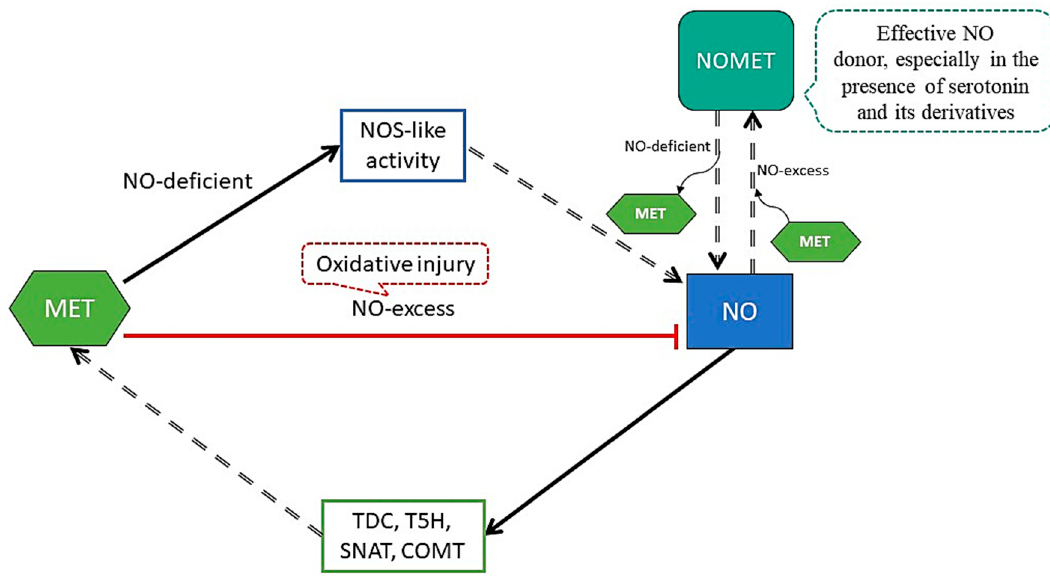
Figure 4. Interaction between melatonin (MET) and nitric oxide (NO). MET promotes the accumulation of NO by increasing the activity of NOS (nitric oxide synthase)-like since MET up-regulates the expression of related genes. MET scavenges excess NO, as it produces oxidative injury (red arrow). In the presence of oxygen, MET can be easily converted to N-Nitrosomelatonin (NOMET) by NO nitrosation under different pH conditions. As well, NOMET is an effective NO donor in cell cultures under the presence of serotonin and its derivatives. On the other hand, through a cyclic guanosine monophosphate (cGMP)-dependent pathway, NO induces the expression of TDC, T5H, SNAT and COMT (genes of the enzymes of the MET biosynthesis pathway) to increase MET levels.